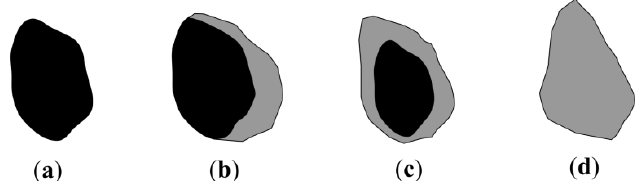
Figure 1. Types of breakstone prepared from crushed concrete waste: ( a ) Natural aggregate; ( b ) Natural aggregate partially covered with old concrete parts; ( c ) Natural aggregate fully covered with old concrete parts; ( d ) crushed old concrete part.